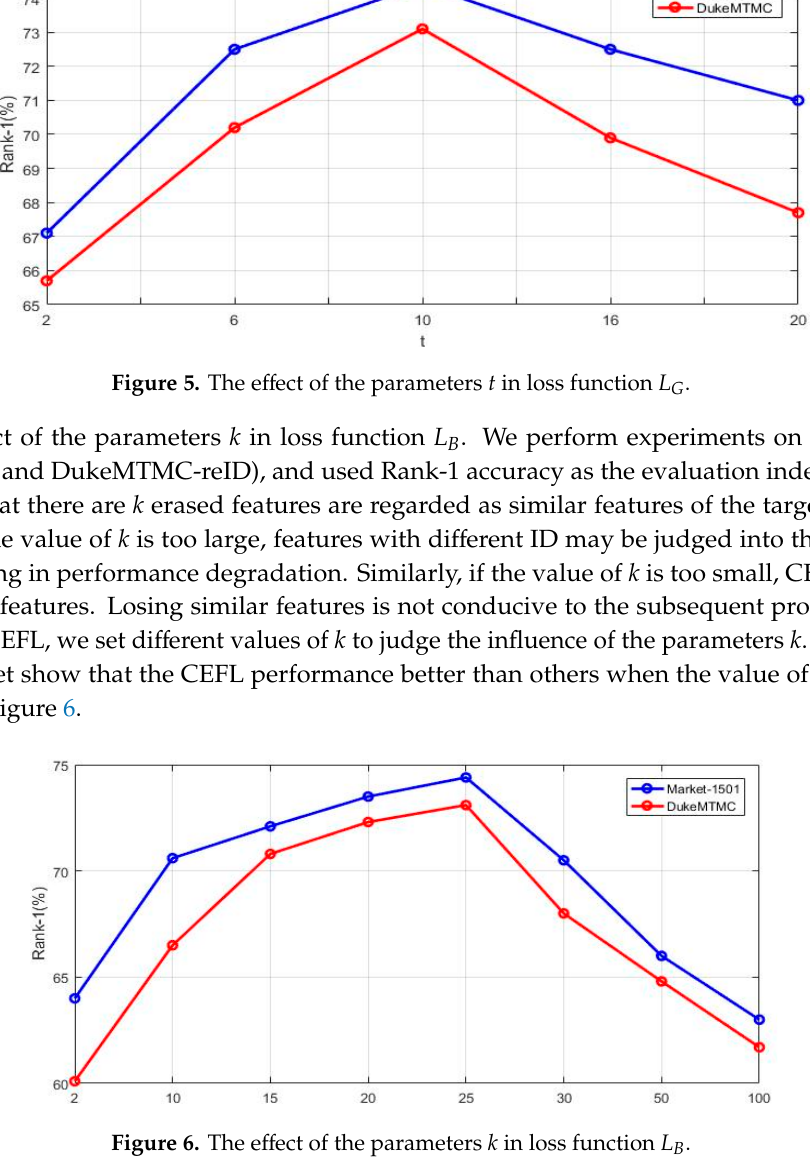
Figure 6. The effect of the parameters k in loss function B L . Figure 6. The e ff ect of the parameters k in loss function L B